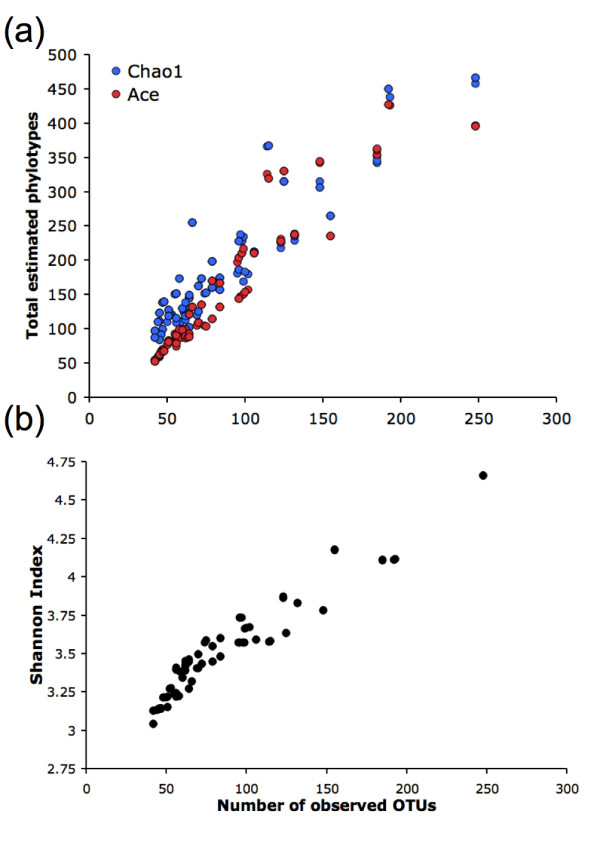
Variability in nonparametric estimators and diversity indices using a clustering distances 0.01-0.05. Plots of (a) Ace and Chao1, and (b) Shannon measures reveal significant sensitivity to OTU sets. Each plotted methodology used either the MUSCLE, ClustalW, or NAST MSA; they also used either furthest, nearest, or average neighbor clustering, and one of the following evolutionary distance corrections: JC, K2P, or F84.